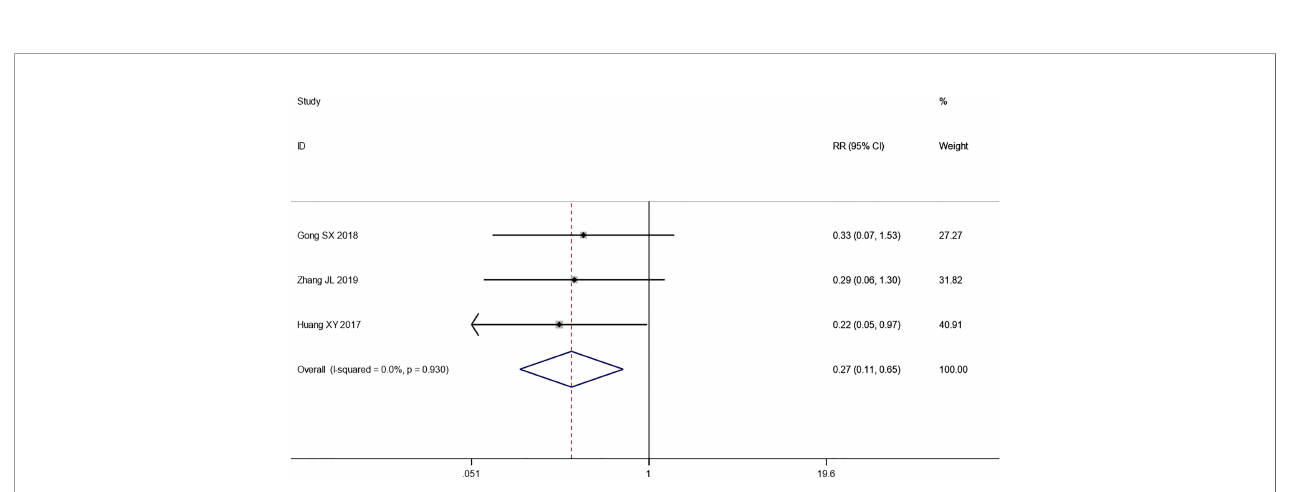
FIGURE 5 | Forest plot of the meta-analysis of progressive disease (PD) between the intervention group and the control group.